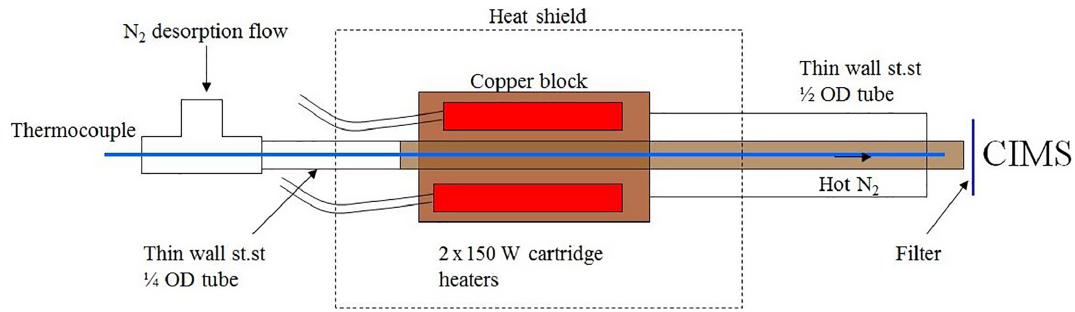
Figure 2. Internal schematic of the FIGAERO desorption gas heater unit (“st.st” is for stainless steel). Temperature above the filter is measured at the end point of the heated tube by the long thermocouple running through the inlet, shown here in blue.